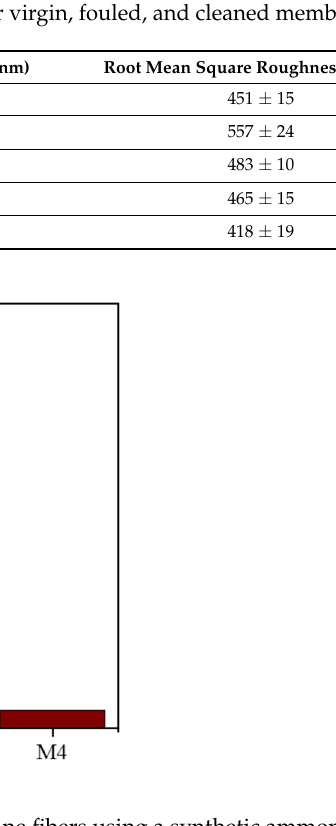
Figure 4. Mass transfer coefficient of tested membrane fibers using a synthetic ammonia solution.